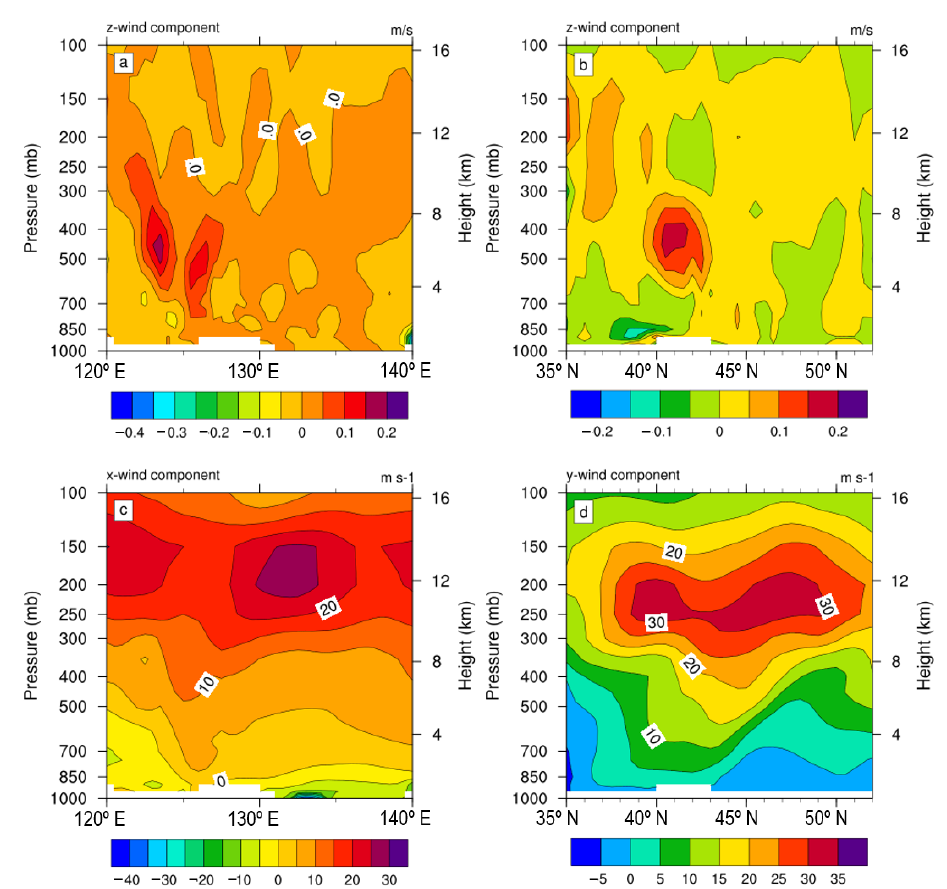
Figure 9. Vertical cross section of vertical velocity (shaded; m/s)) along 42.5 ◦ N ( a ), and 126.5 ◦ E ( b ) vertical cross section of u (shaded; m/s) along 42.5 ◦ N ( c ), and v(shaded; m/s) along 126.5 ◦ E ( d ) at 19 UTC on 14 August 2019.